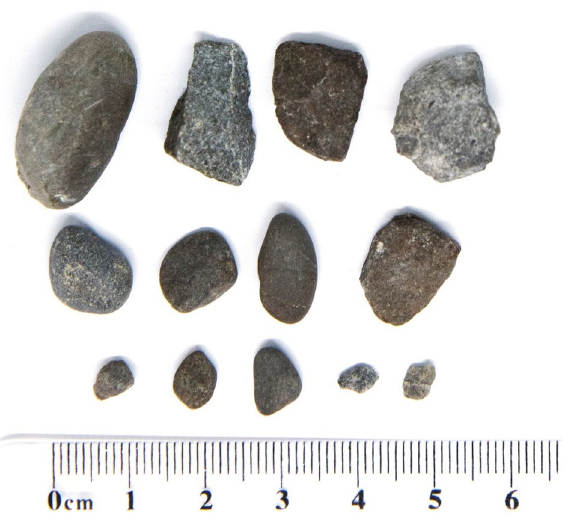
Figure 2. Photographs of pebbles and stones randomly sampled from the aviary by the